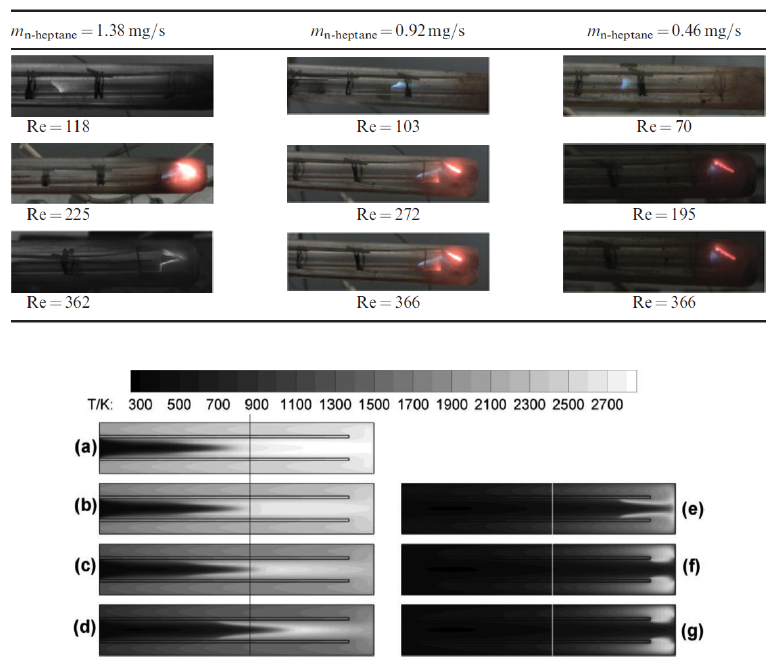
Figure 7. Experimental and numerical study of diffusion combustion in a micro channel using liquid n-heptane and air mixture, with and without heat recirculation, by Li et al. [17]. Top : Photos of flame at different Reynolds numbers ( b ); Bottom : Temperature contours for various heat loss coefficients: ( h Unit: W/m 2 − K ): ( a ) h = 0, ( b ) h = 1, ( c ) h = 10, ( d ) h = 20, ( e ) h = 50, ( f ) h = 75, ( g ) h =